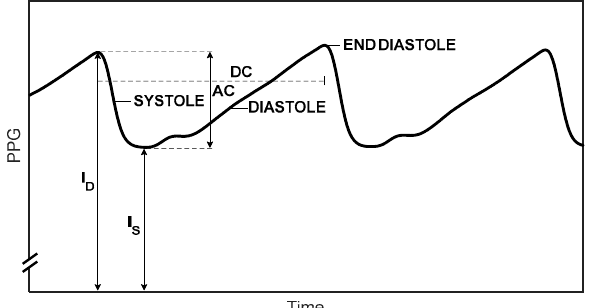
Figure 1. The photoplethysmography (PPG) pulses. The transmitted light through the tissue decreases during systole and increases during diastole. AC is the difference between the maximal (I D ) and minimal (I S ) light transmission through the tissue; DC is the mean light transmission through the pulse.